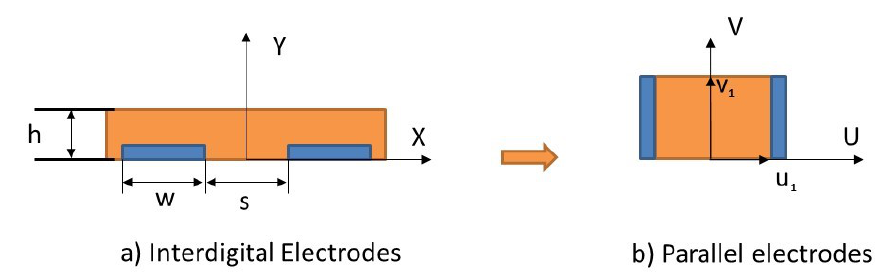
Figure 8. Representation of two fingers structure in the (x, y) plane ( a ), and after conformal mapping in the (u, v) plane ( b